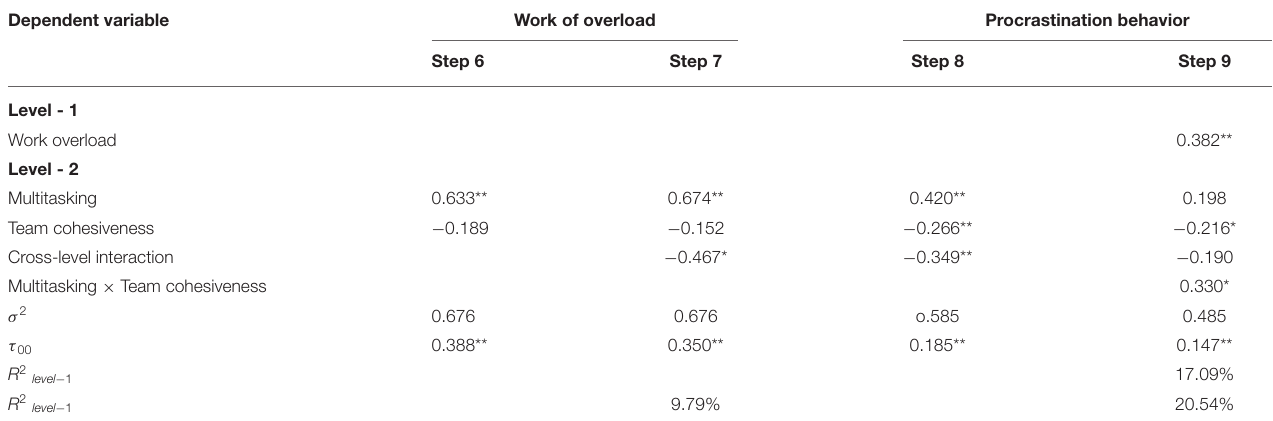
TABLE 4 | Moderating effect of team